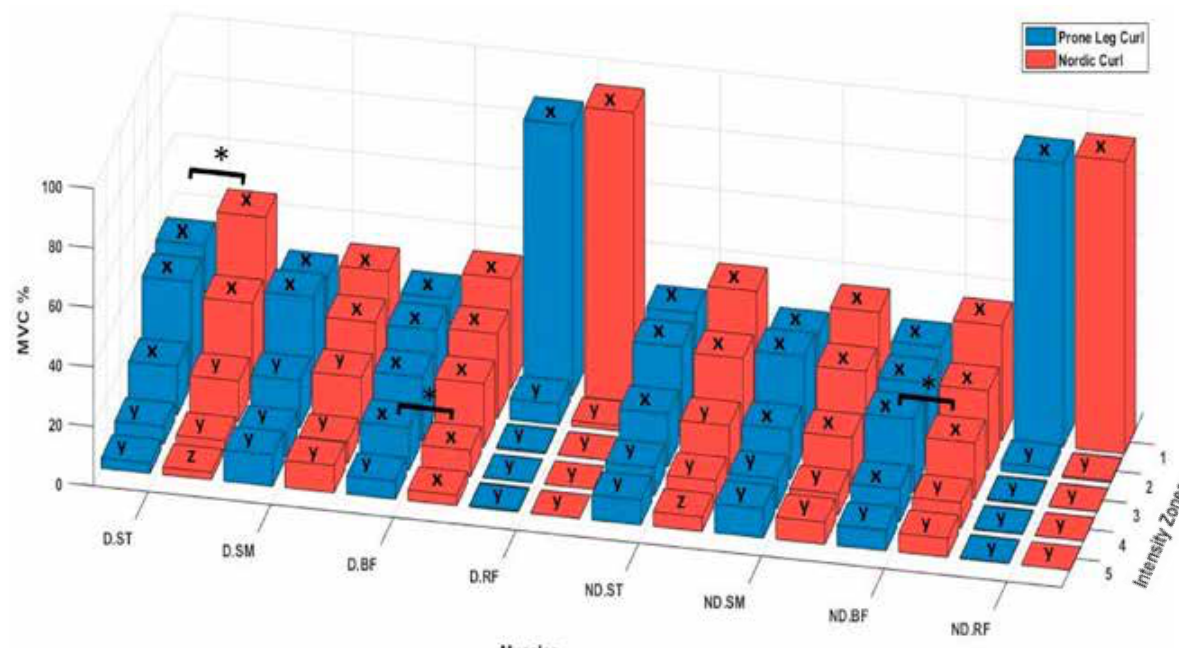
Figure 7. Comparison of activity rates of the muscles in 5 intensity zones during the PLC and NC Exercises * Symbol refers to the significance of the difference between the PLC and NC (p<0.05). The letters refer to the significance of the difference between activity rates in each intensity zone (p<0.05). D.ST: Dominant semitendinosus, D.SM: Dominant semimembranosus, D.BF: Dominant Biceps femoris, D.RF: Dominant rectus femoris, ND.ST: Nondominant semitendinosus, ND.SM: Nondominant semimembranosus, ND.BF: Nondominant bicepsfemoris, ND.RF: Nondominant rectus